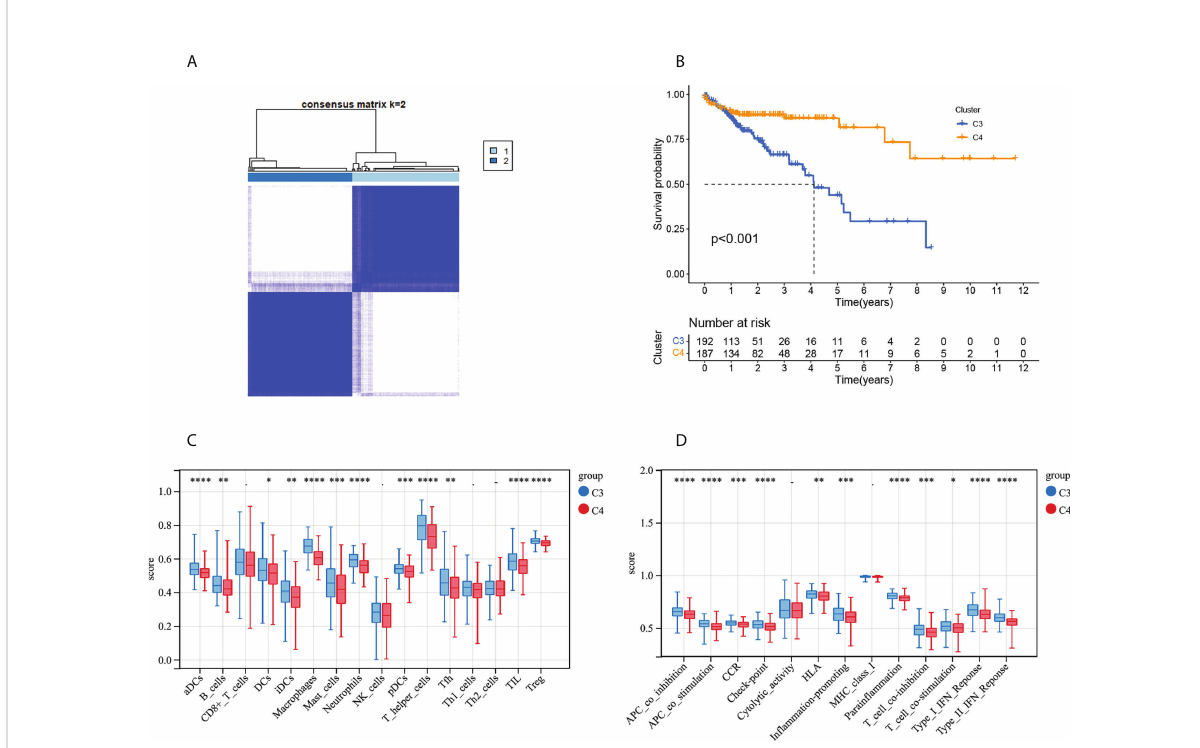
FIGURE 6 Tumor classi fi cation based on the MMRG-related gene. (A) COAD patients were grouped into two clusters according to the consensus clustering matrix (k = 2). (B) Kaplan – Meier curves for the two clusters. (C) Relative in fi ltration of 16 types of immune cells in MMRG-related gene clusters C3 and C4. (D) Relative enrichment score of 13 immune-related functions in MMRG-related gene clusters C3 and C4. *p < 0.05; **p < 0.01; ***p < 0.001; ****p <